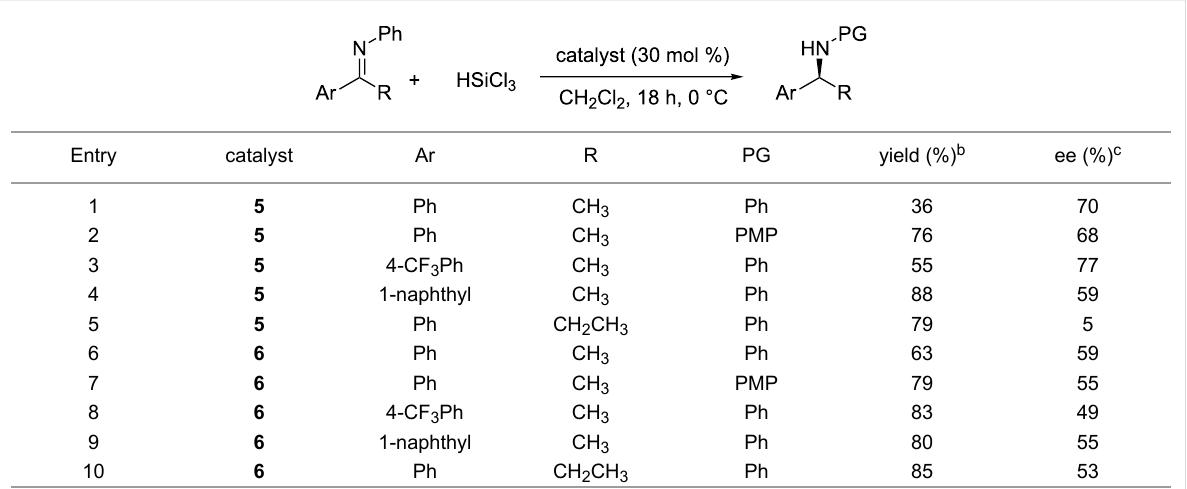
Table 3: Enantioselective reduction of differently substituted imines. a